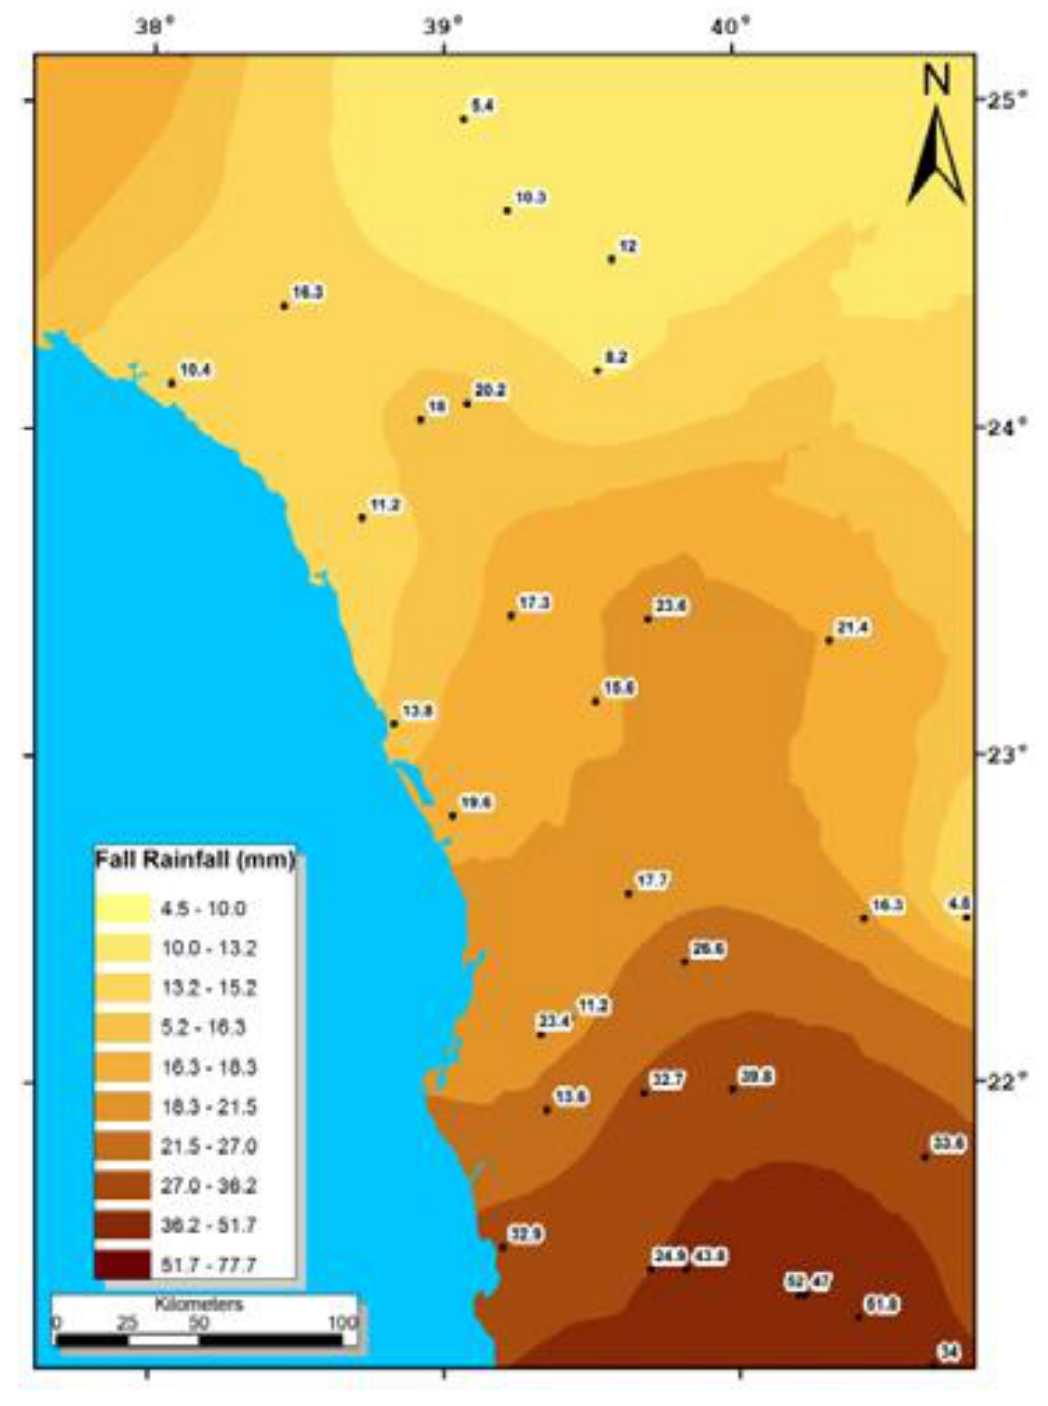
Figure 13. Isohyetal map for fall rainfall